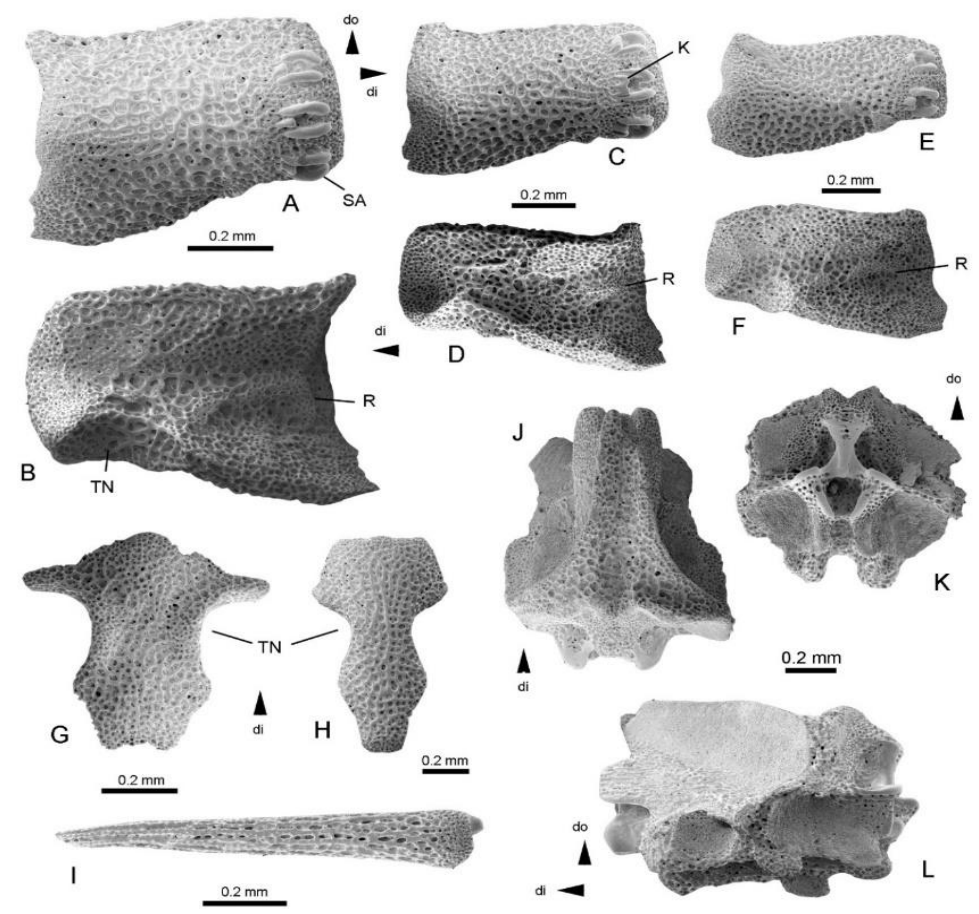
Figure 4. Ophiodoris niersteinensis sp. nov. from the Rupelian, Oligocene (Rosenheim Subformation, Bodenheim Formation, nannoplankton zone NP 24 and to dinoflagellate zones D 14/D 15) of a flush drill made at Nierstein, Rhineland-Palatinate, Germany. Holotype (NHMMZ PWL 2022/5561.1-LS), dissociated proximal lateral arm plate in external ( A ) and internal ( B ) views; paratype (NHMMZ PWL 2022/5561.2-LS), dissociated median lateral arm plate in external ( C ) and internal ( D ) views; paratype (NHMMZ PWL 2022/5561.3-LS), dissociated distal lateral arm plate in external ( E ) and internal ( F ) views; paratype (NHMMZ PWL 2022/5561.4-LS), dissociated proximal ventral